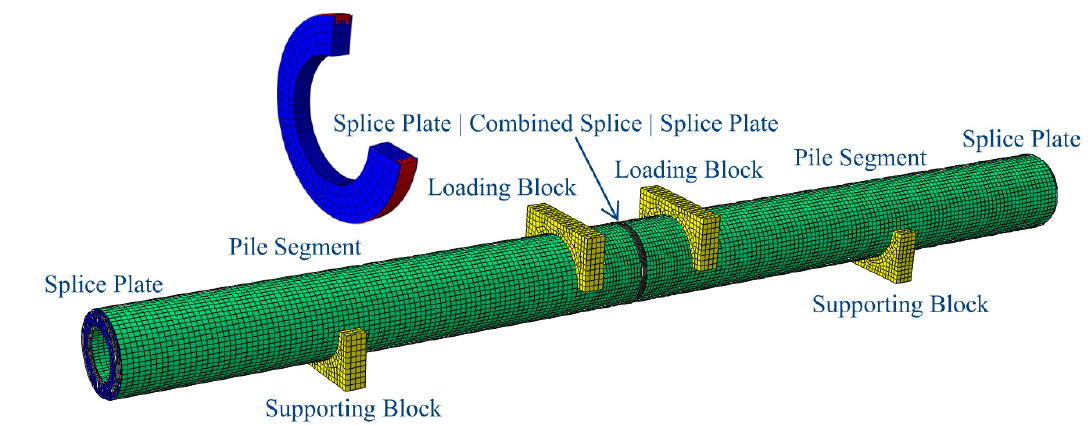
Figure 13. Schematic diagram of the finite element model.